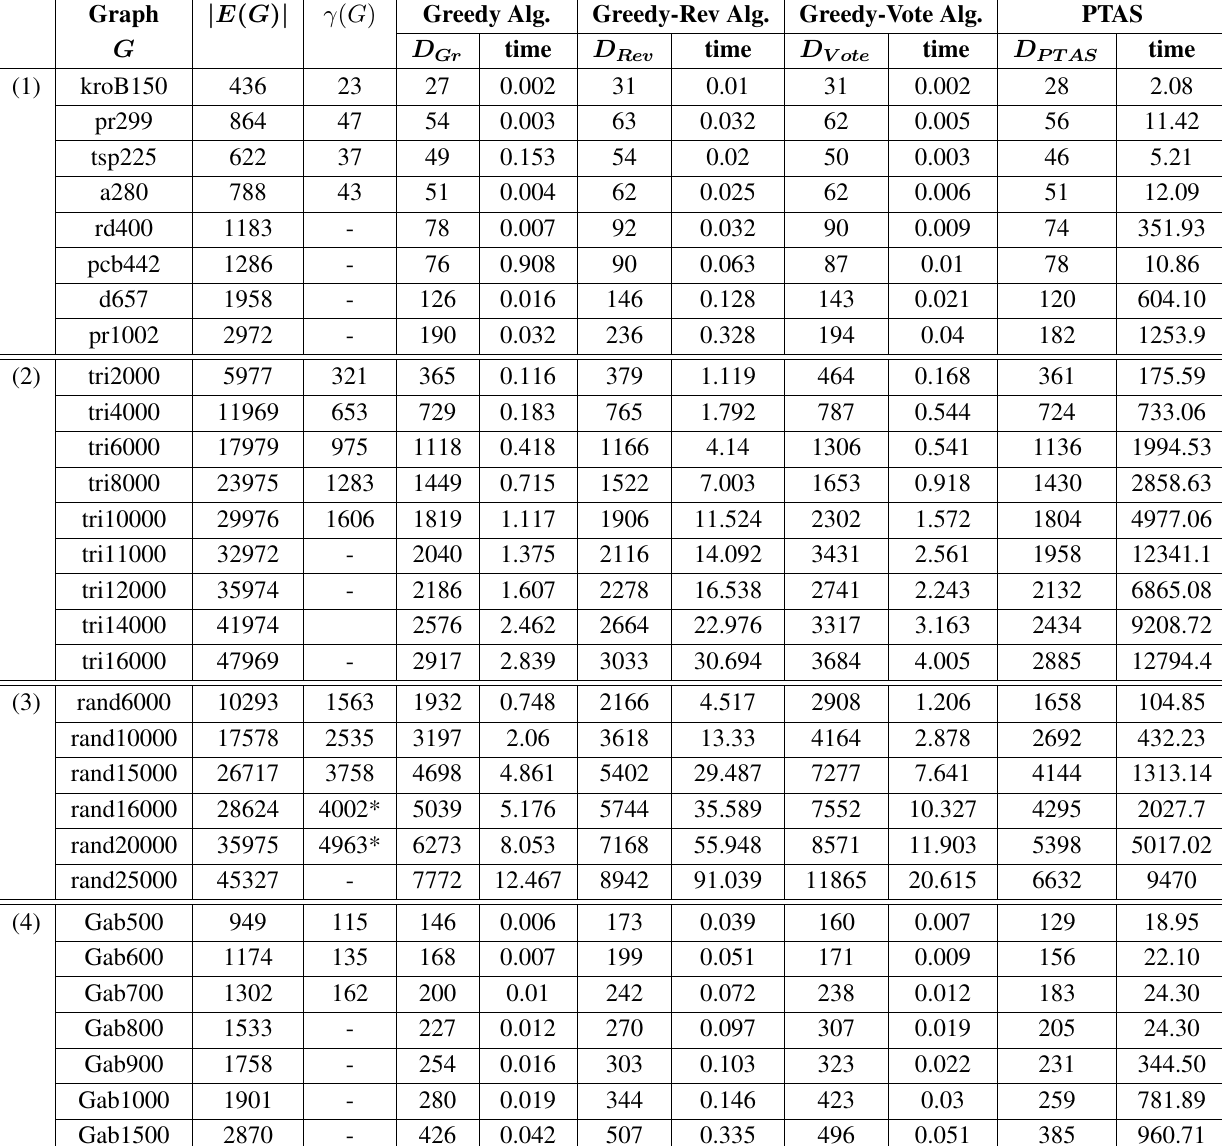
Table 2. Computational results for heuristic algorithms and PTAS for the planar dominating set problem (time in